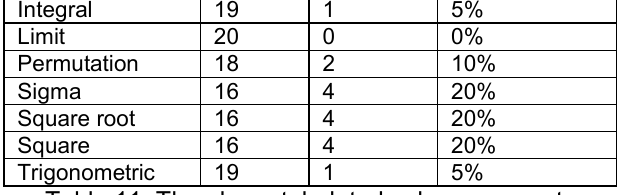
Table 11. The above tabulated value represents overall FNR Measure with Tensorflow from a document of 40 samples.